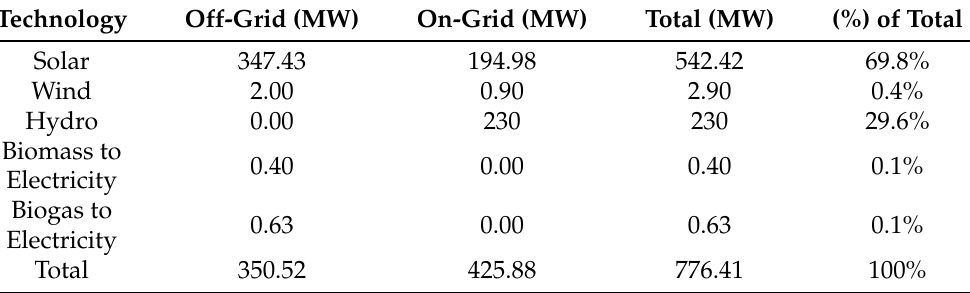
Table 2. Off-grid and on-grid RE capacities of Bangladesh [45]. Technology Off-Grid (MW) On-Grid